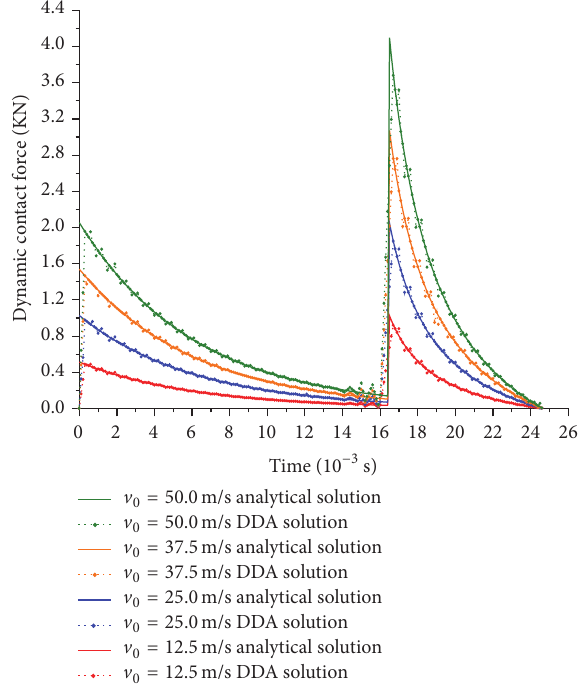
Figure 8: Dynamic contact force-time curve with different values of Young’s modulus. Figure 9: Dynamic contact force-time curve for different initial impact